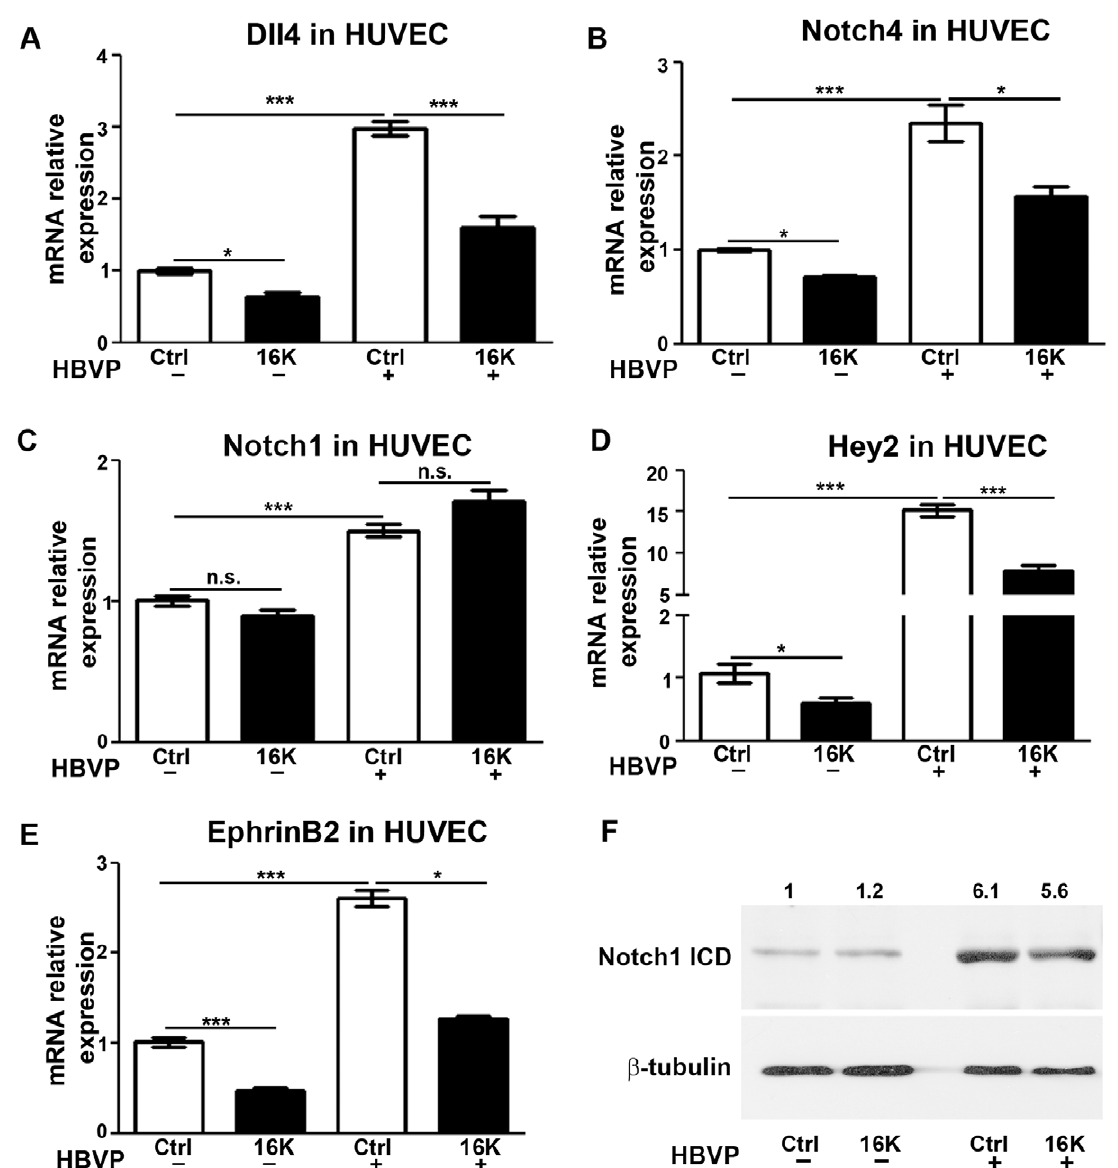
Figure 6. Decreased expression of Notch factors in HUVEC cocultured with HBVP after 16K hPRL treatment. (A–E) HUVEC pretreated for 30 min with 100 nM 16K hPRL (16K) were cultured for 6 h in the presence or absence of HBVP. The two cell populations were then separated prior to qRT-PCR analysis and subjected to qRT-PCR analysis to detect DLL4 , NOTCH4 , NOTCH1 , HEY2 and EPHRINB2 transcripts. (F) Western blot analysis to detect Notch1 ICD. Data are presented as means 6 SEM, n=3 and are representative of at least two different experiments. n.s., non significant. *, P , 0.05; ***, P , 0.0001.